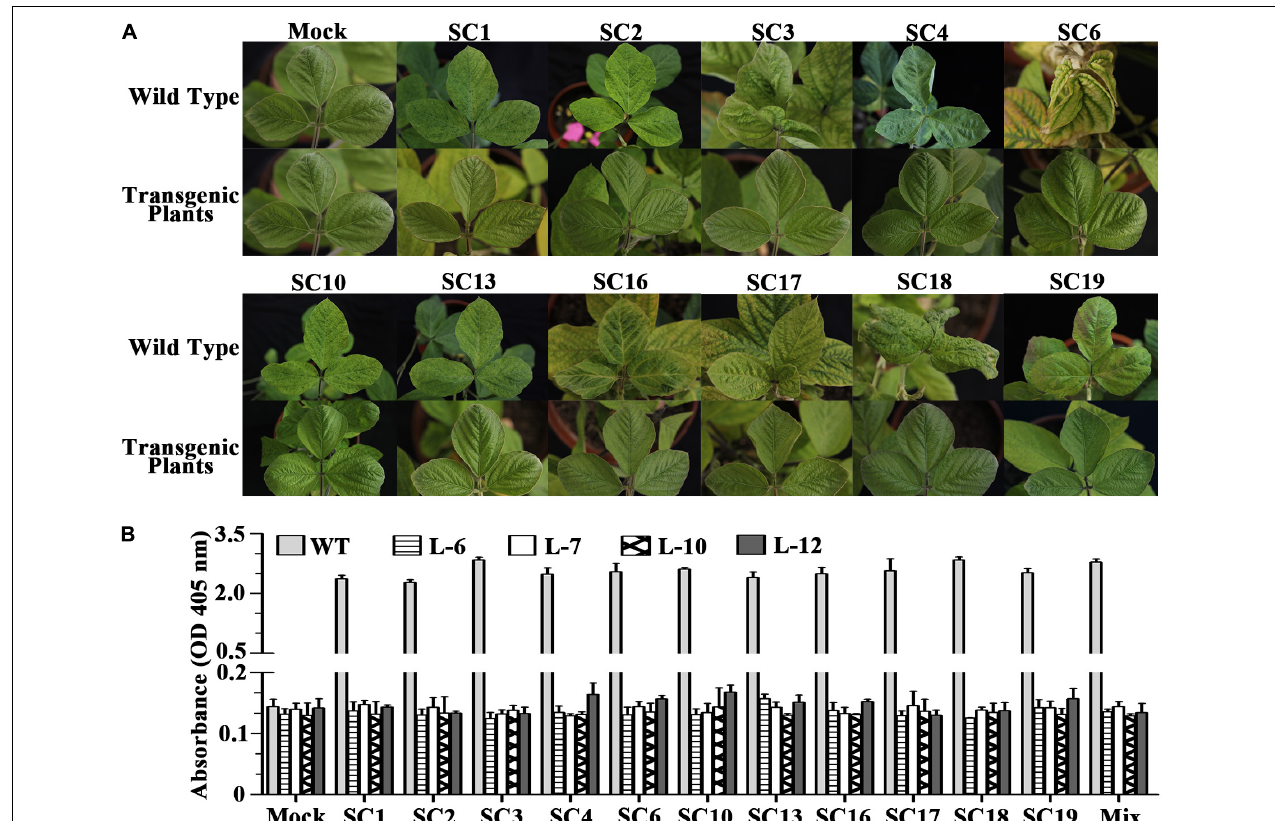
FIGURE 3 | Responses of the non-transgenic and T 3 transgenic soybean plants to SMV inoculation. (A) The photographs of the systemic leaves of SMV-inoculated non-transgenic and T 3 transgenic plants were taken at 28 dpi. Wild Type = receptor soybean variety NN1138-2; Transgenic plants are those of Line L-6; Mock: non-inoculated plants as controls. SC1, SC2, SC3, SC4, SC6, SC10, SC13, SC16, SC17, SC18, and SC19: different SMV strains. (B) ELISA detection of SMV coat protein in the systemic leaves of SMV-inoculated non-transgenic (WT = NN1138-2) and four transgenic lines (L-6, L-7, L-10, and L-12) at 28 dpi. Mix: a mixed inoculum of the above eleven SMV strains. The error bars indicate standard deviations with N =